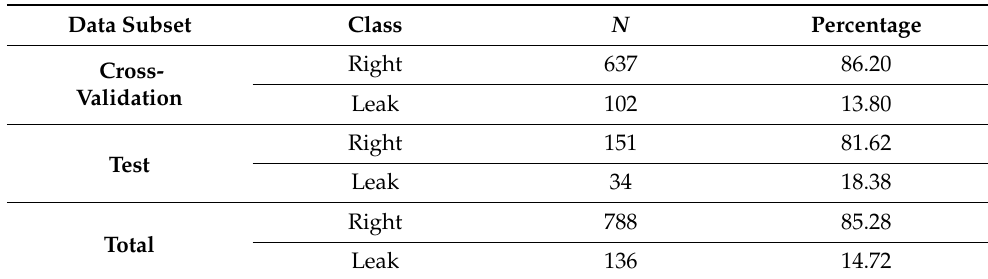
Table 2. Number of cases and percentage distribution of the classes for the subset of bellows-type data into which the initial dataset was